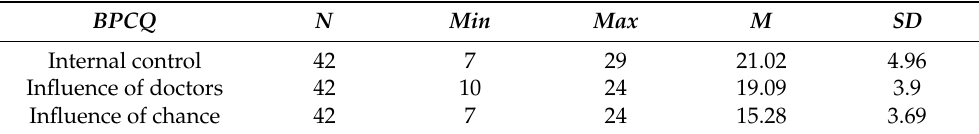
Table 1. Pain-control